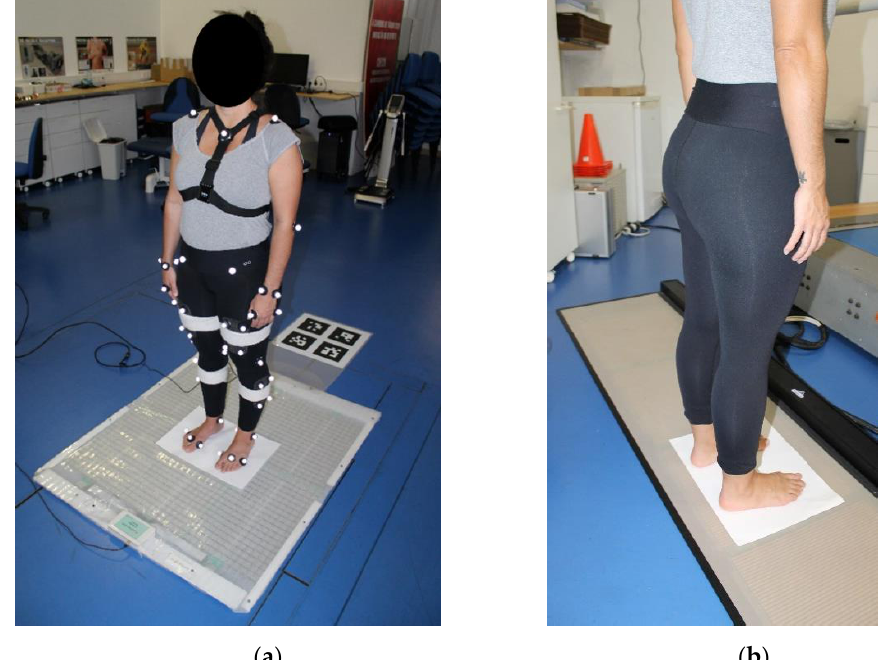
Figure 6. Representation of the center of mass experimental setup with a participant ( a ) standing on the Equimetrix mat while wearing the camera and retroreflective markers and ( b ) on the podobarometric pressure platform during the base of support measurement.